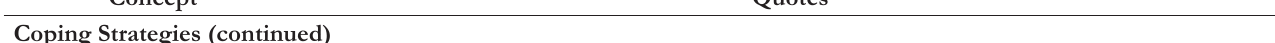
Table 2. Concepts and Illustrative Quotes Pertaining to Those Concepts - continued